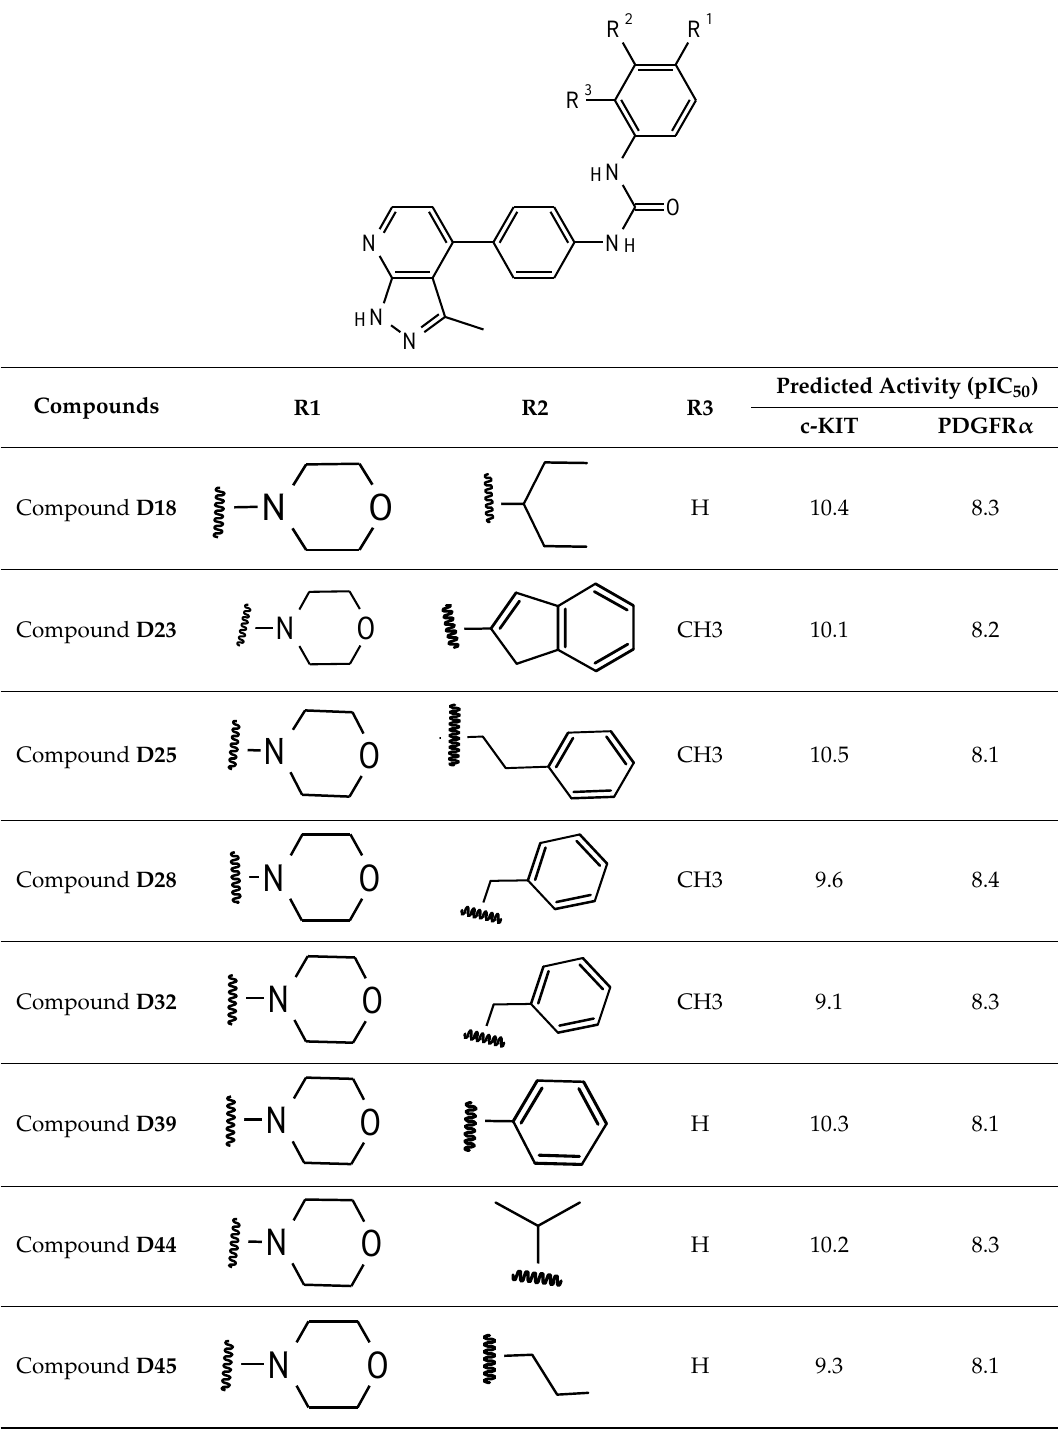
Table 5. The chemical structures and the predicted pIC 50 values of the newly designed compounds for c-KIT and PDGFRα.